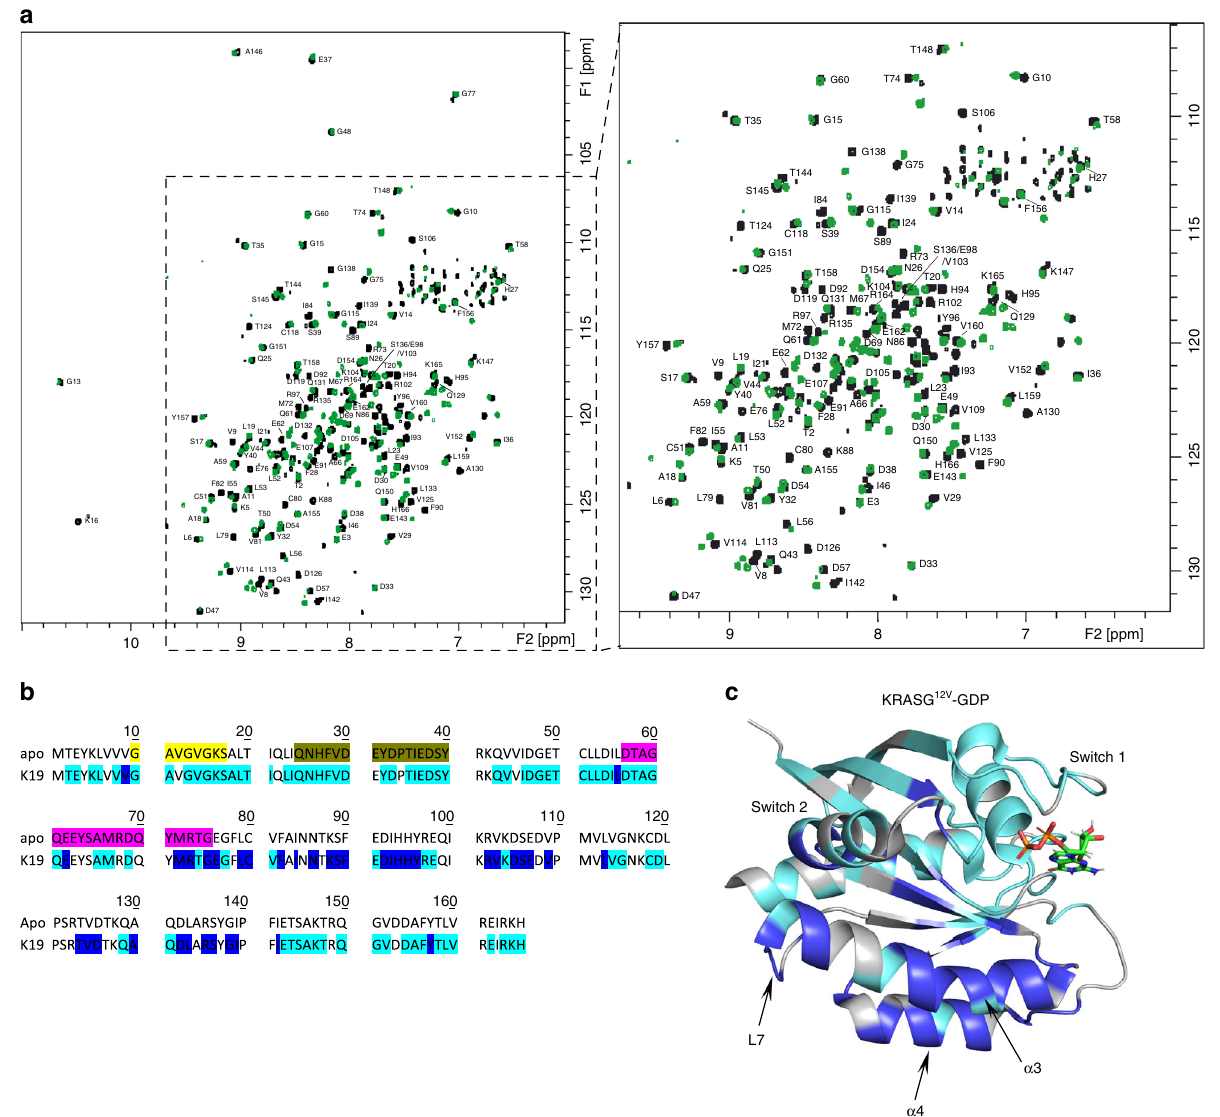
Fig. 2 HSQC NMR chemical shift changes in KRAS after DARPin K19 binding. a Comparison between 1 H, 15 N TROSY spectra for apo KRAS G12V at 100 μ M (black) overlaid with K19-bound KRAS G12V at 89 μ M (green). DARPin concentrations were in slight excess. An expanded region is shown on the right. b Amino acids undergoing chemical shifts upon DARPin K19 binding on KRAS G12V -GDP are shown in blue, residues not experiencing shifts are shown in turquoise in the KRAS G12V sequence (unassigned residues are not highlighted). The P-loop is highlighted in yellow, the switch 1 in dark yellow and the switch 2 in purple. c Ribbon representation of ( b ) with amino acids undergoing chemical shifts in blue and residues not experiencing shifts in turquoise in the KRAS G12V -GDP structure (PDB 4TQ9) after DARPin K19 binding (unassigned residues are in grey). L7: loop 7, α 3: helix 3, α 4: helix